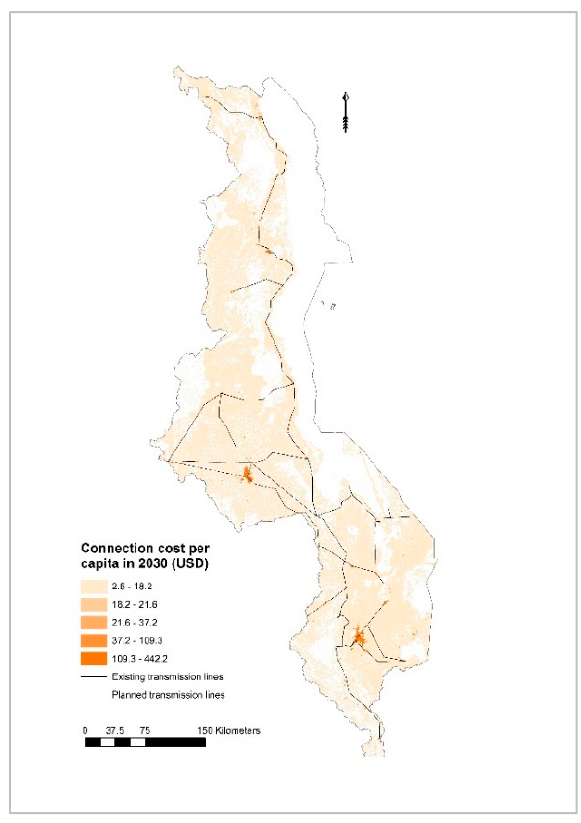
Figure 9. Connection cost per capita based on the least cost option identified in the selected electrification scenario.